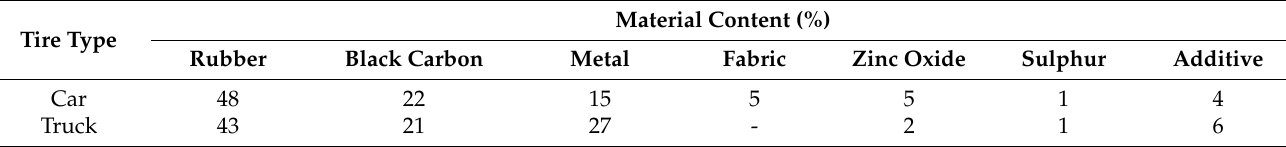
Table 2. Comparison of tire composition between car and truck.